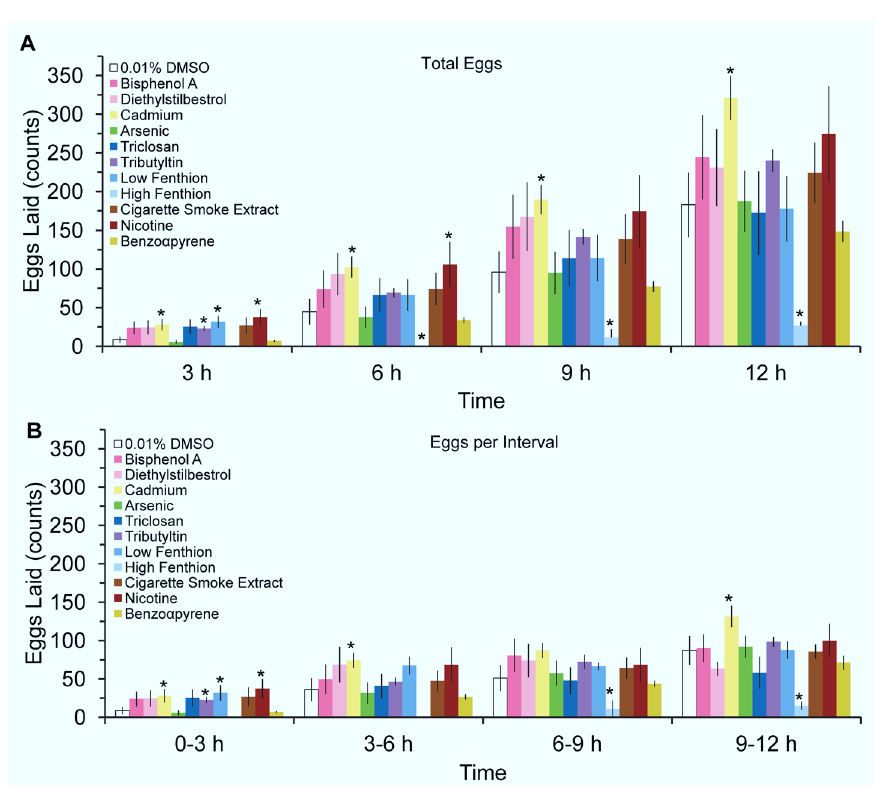
Figure 3. Effects of teratogens on egg-laying. Temporal pattern of ( A ) cumulative eggs laid at 3, 6, 9 and 12 hours post-exposure, and ( B ) rate of eggs laying in 3 hours intervals (mean ± sem). Asterisks indicate P